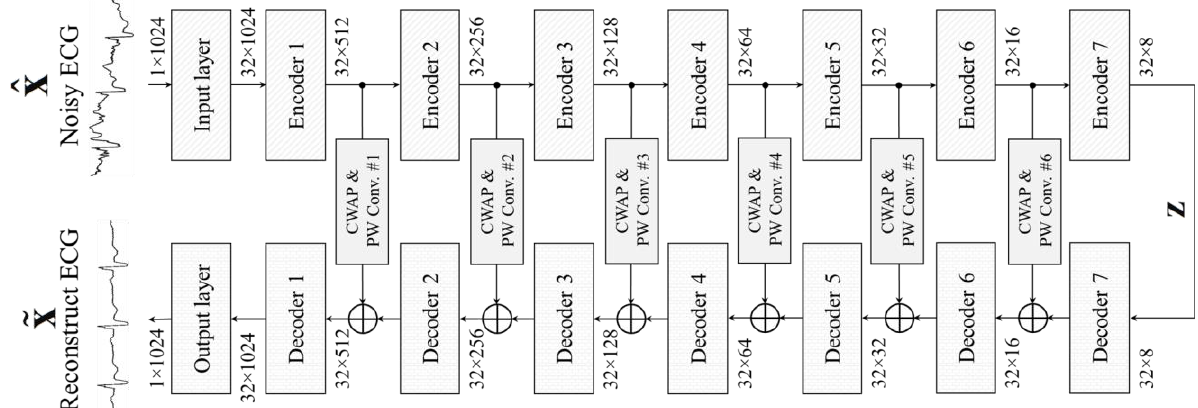
Figure 5. Architecture of the regular version of the proposed CPDAE.